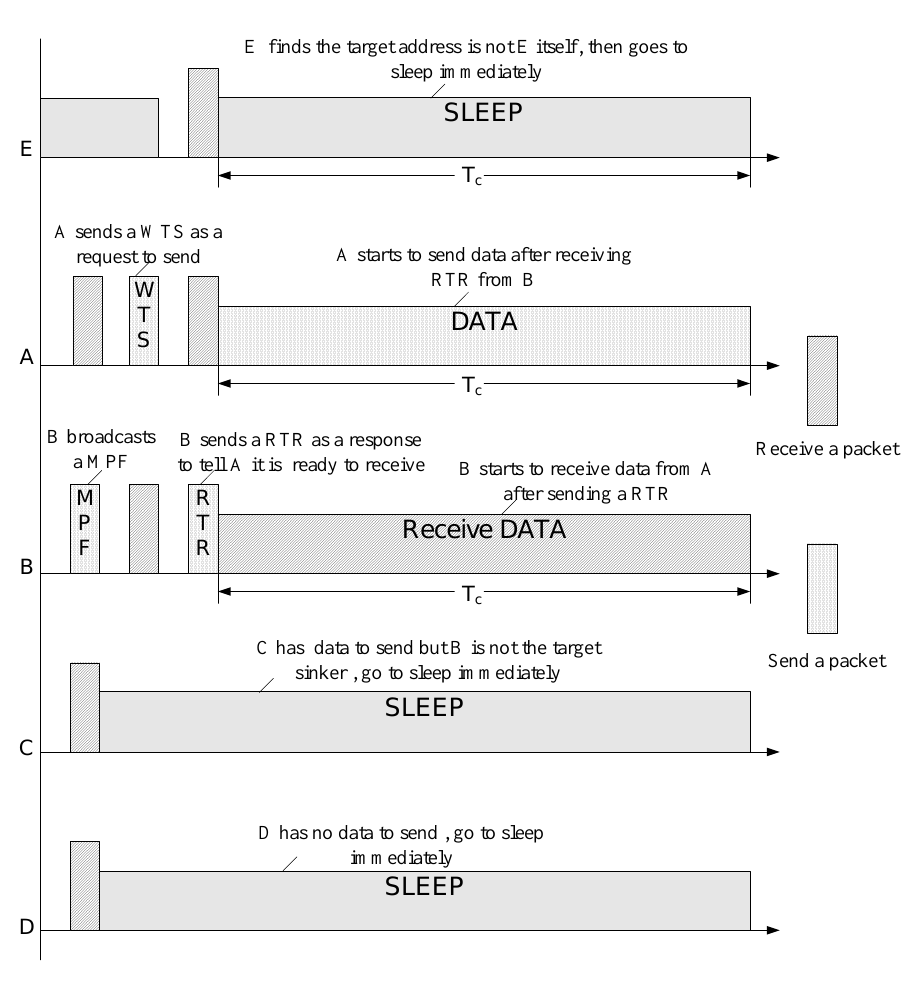
Figure 2. Data Delivery Initiated by Target